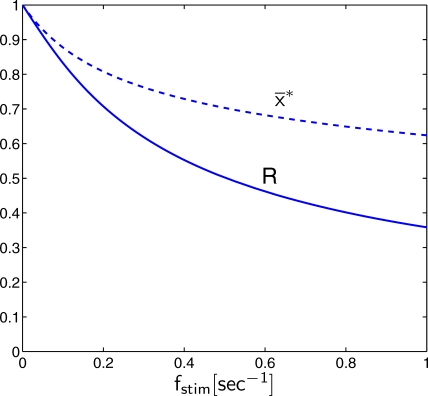
Frequency-Dependent Adaptation in the Theoretical Symmetric SystemState variables and responsiveness decrease monotonically as stimulation frequency is increased. The curve was calculated for the symmetric system satisfying Equation 11 where the system's activity functions are the sigmoidal activity function given in Equation 12 (a = 16.67; b = 10; θ = 5; U = 0.5; τ = 10 s).